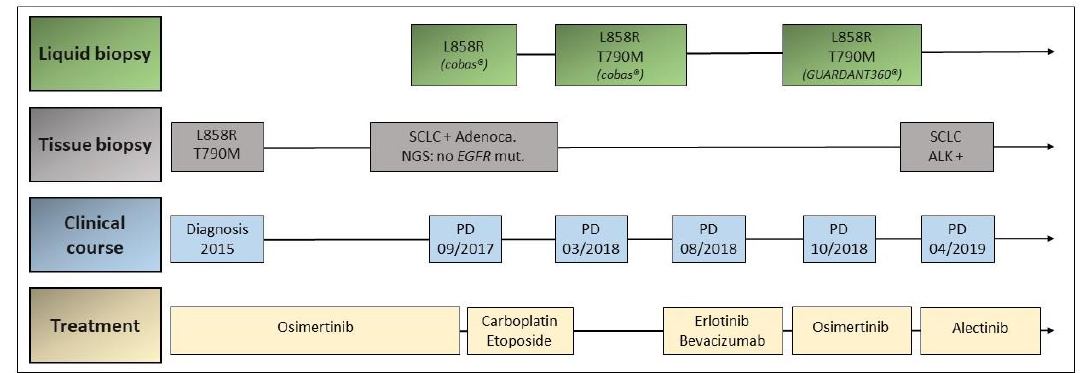
Figure 3. Timeline of disease and treatment course in case 2. Adenoca.: adenocarcinoma; mut.: mutation; NGS: next-generation sequencing; PD: progressive disease; SCLC: small-cell lung cancer.